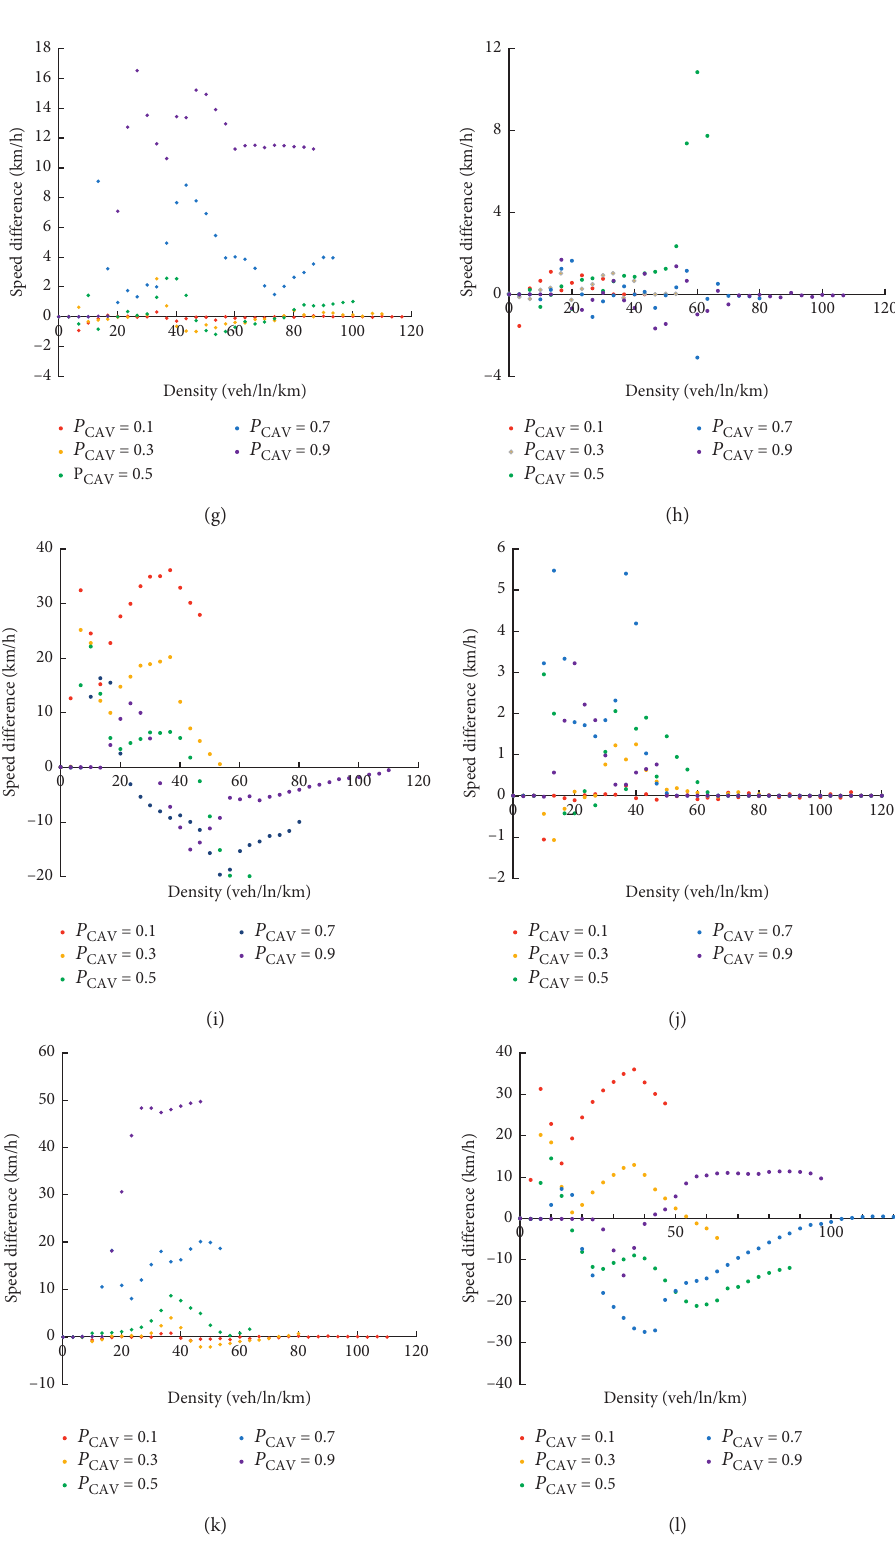
Figure 3: Speed different diagram. Speed difference between (a) GC and GM, (b) GG and GC, (c) GG and CM, (d) GCG and CGG, (e) GGG and GCG, (f) GMG and MGG, (g) GGG and GMG, (h) CGC and CCG, (i) GGG and CGC, (j) MGM and MMG, (k) GGG and MGM, and (l) GGG and